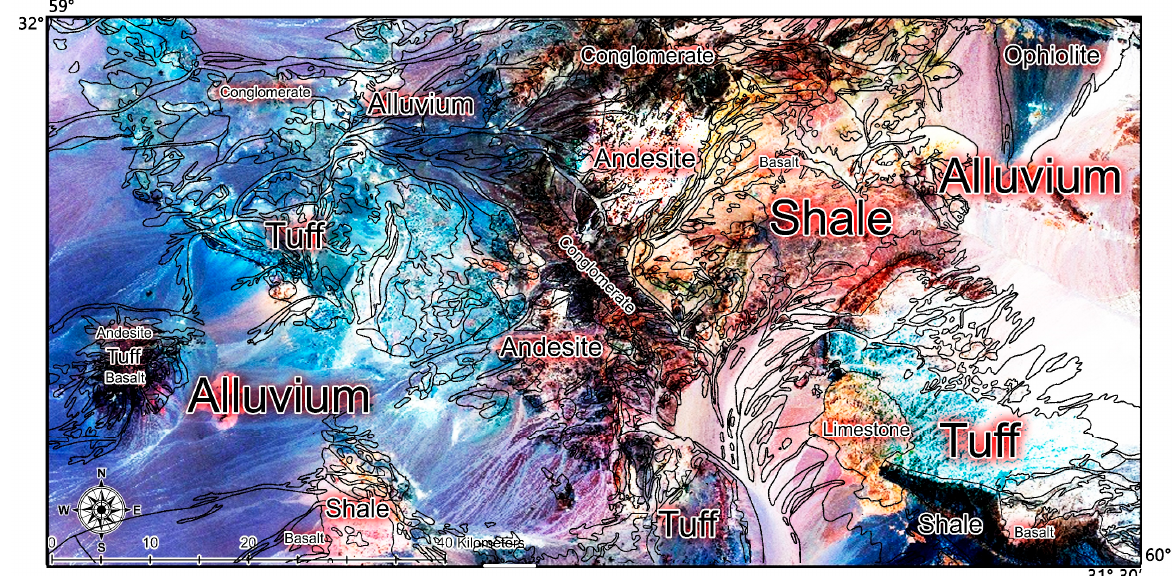
Figure 5. The resulting image from the RGB band composition of 5-3-1 on the ETM + satellite sensor was determined by the OIF.